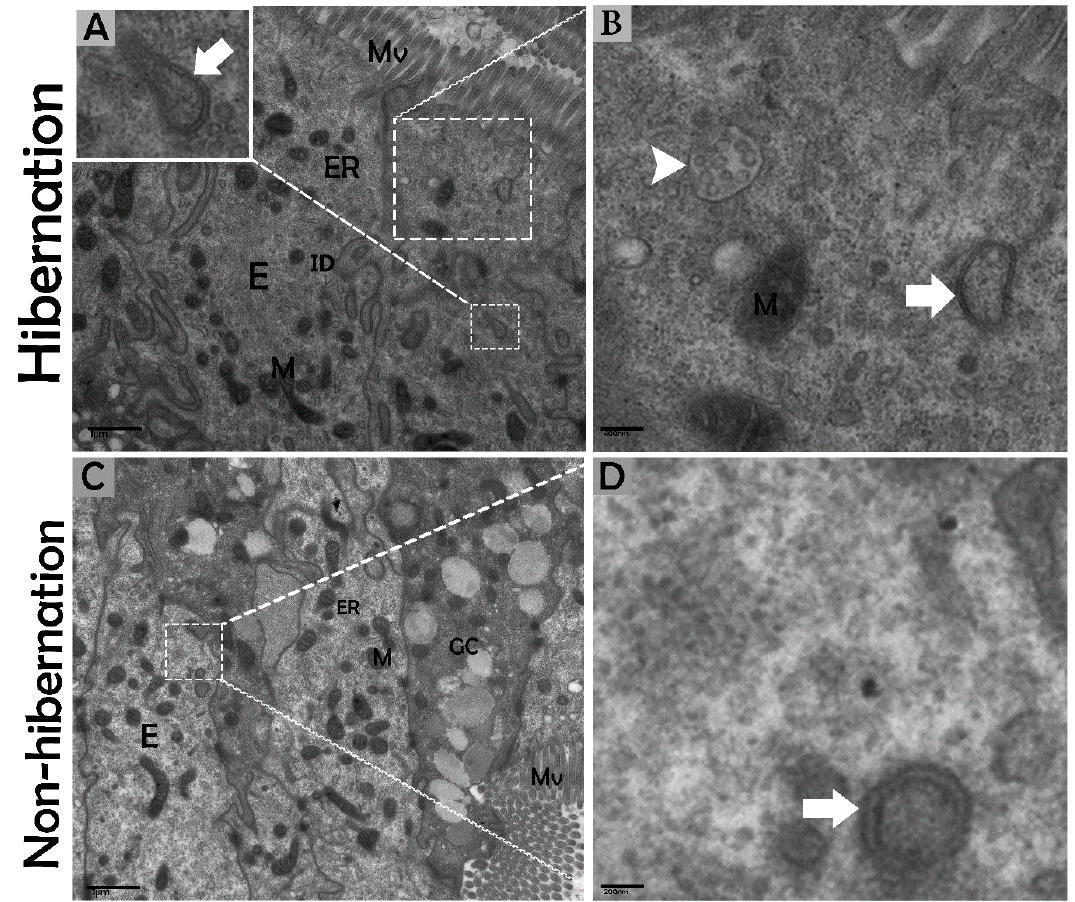
Figure 5. Formation of phagophores in enterocytes of the small intestine in P. sinensis during hibernation ( A , B ) and nonhibernation periods ( C , D ). E, enterocyte; GC, goblet cell; M, mitochondria; ER, endoplasmic reticulum; ID, interdigitation; multivesicular bodies (white arrow head), phagophore (white bold arrow). Scale bar = 1 µm ( A , C ), 400 nm ( B ), and 200 nm ( D ).